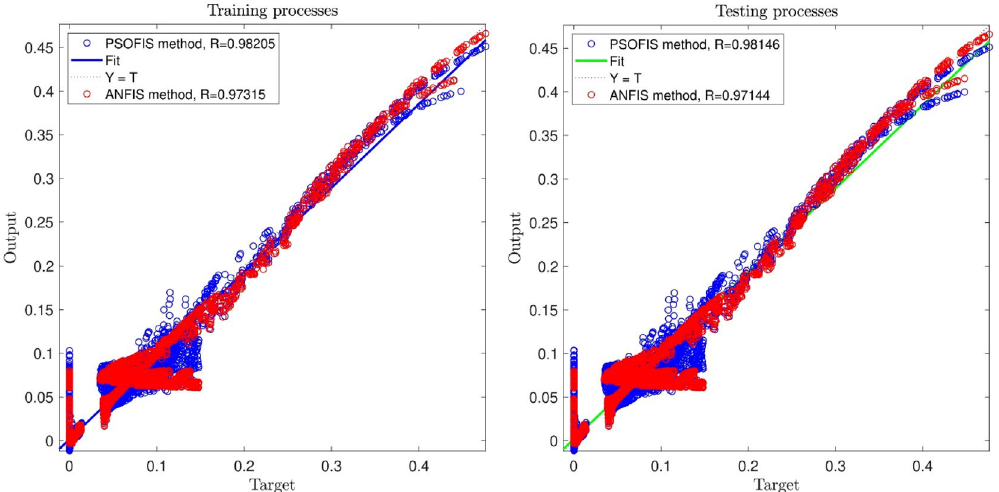
Figure 7. Comparison of the best result of PSOFIS and ANFIS methods.